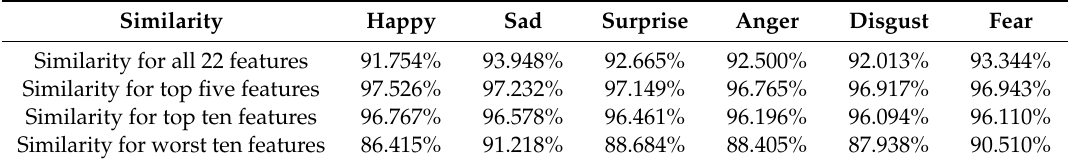
Table 9. The SS for all six-expression using all features, top five, top ten, worst ten.